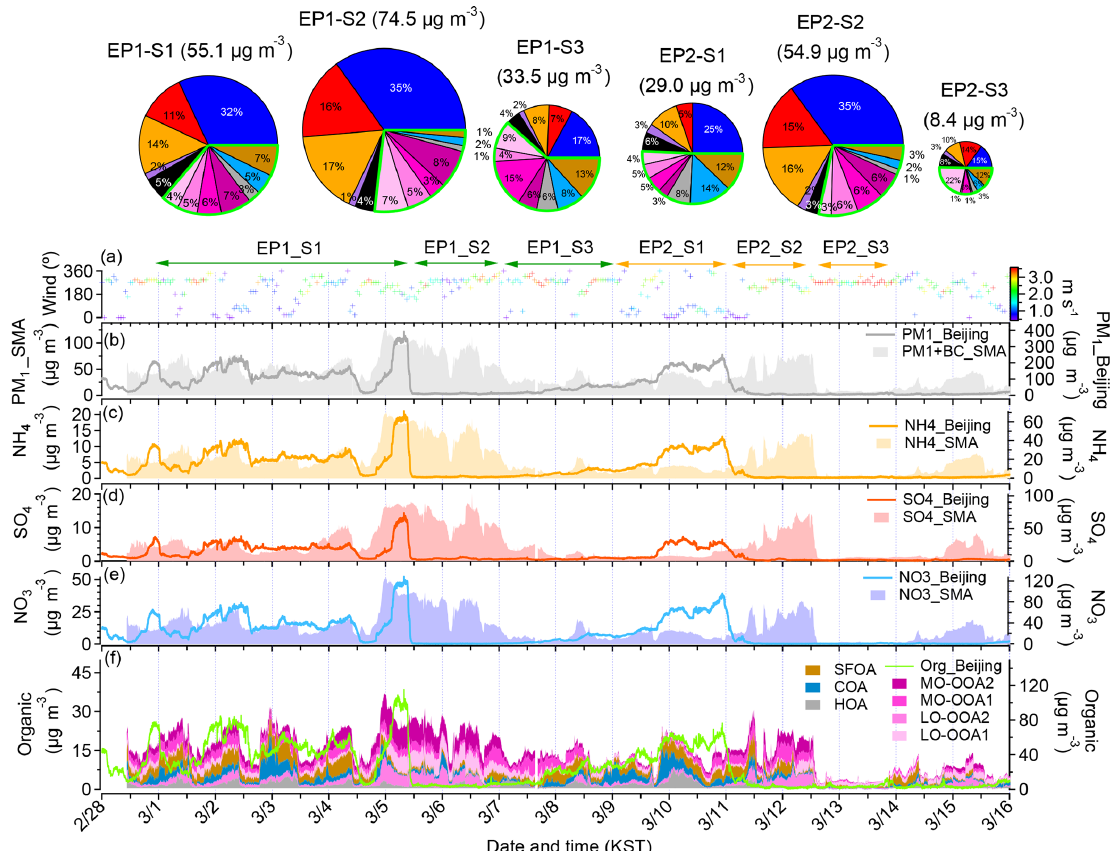
Figure 5. Overview of the chemical composition of the submicron aerosols at the Korea Institute of Science and Technology (KIST) in the SMA and Beijing from 28 February to 16 March 2019, including two haze episodes: (a) time series of the wind direction (WD), with the colors showing the different wind speeds (WSs) in the SMA; (b) time series of PM 1 + BC in the SMA and of PM 1 in Beijing; (c) time series of ammonium (NH + ) in the SMA and Beijing; (d) time series of sulfate (SO 4 ) in the SMA and Beijing; (e) time series of nitrate (NO − 4 the SMA and Beijing; (f) time series of the organic and stacked contributions of the sources of the OA in the SMA and Beijing. Note that the time series of each species in Beijing is modified to KST based on Beijing